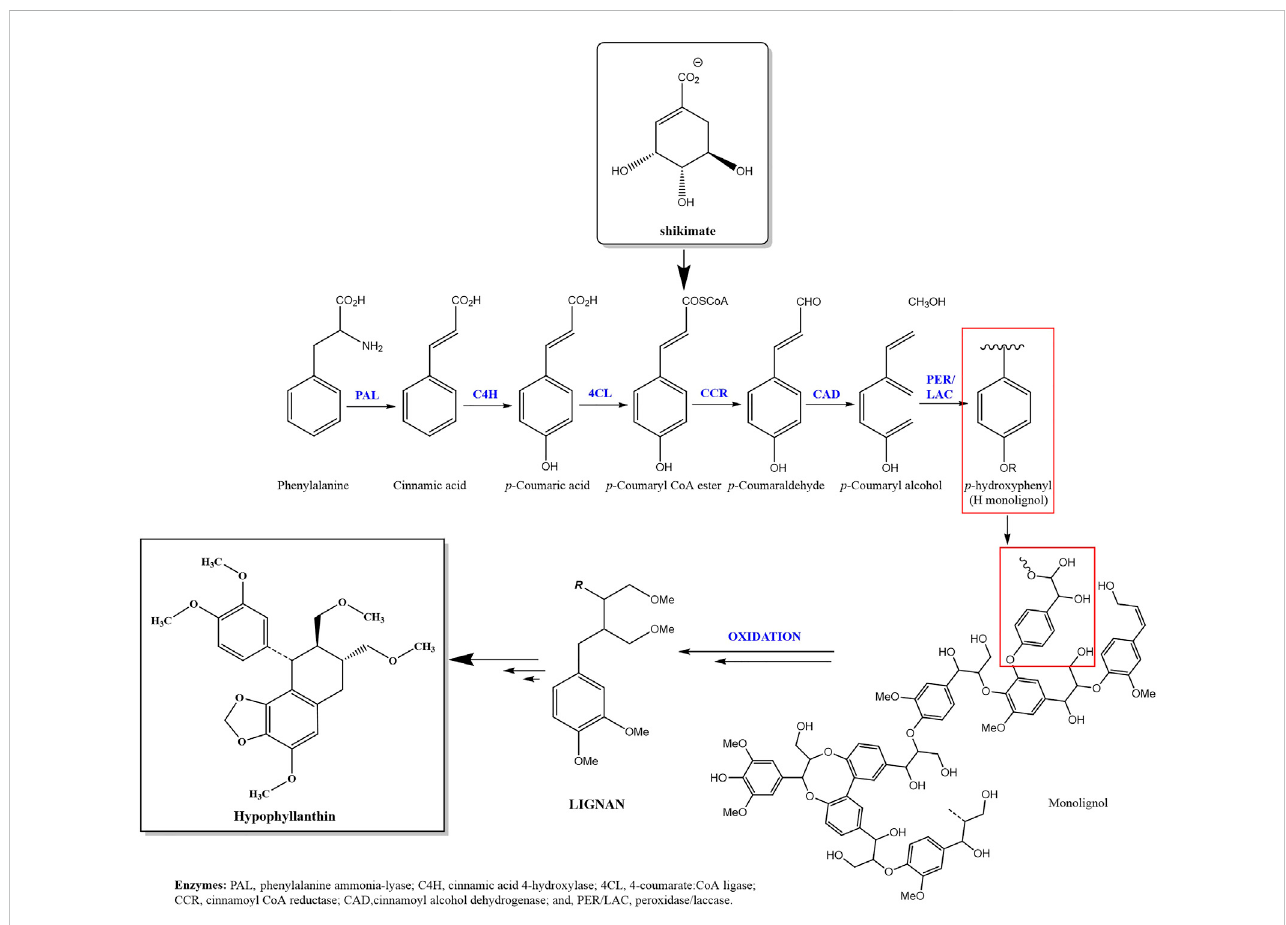
FIGURE 2 Proposed biosynthetic pathway for